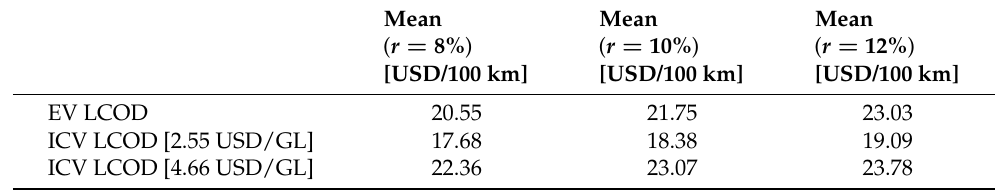
Table 3. LCOD result obtained from a Monte Carlo simulation with 10 3 realizations.